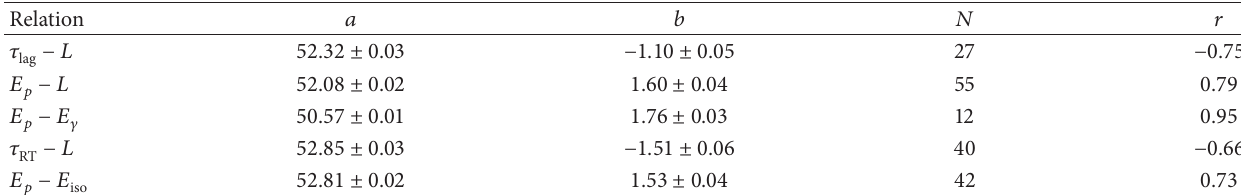
Table 2: Best-fitting